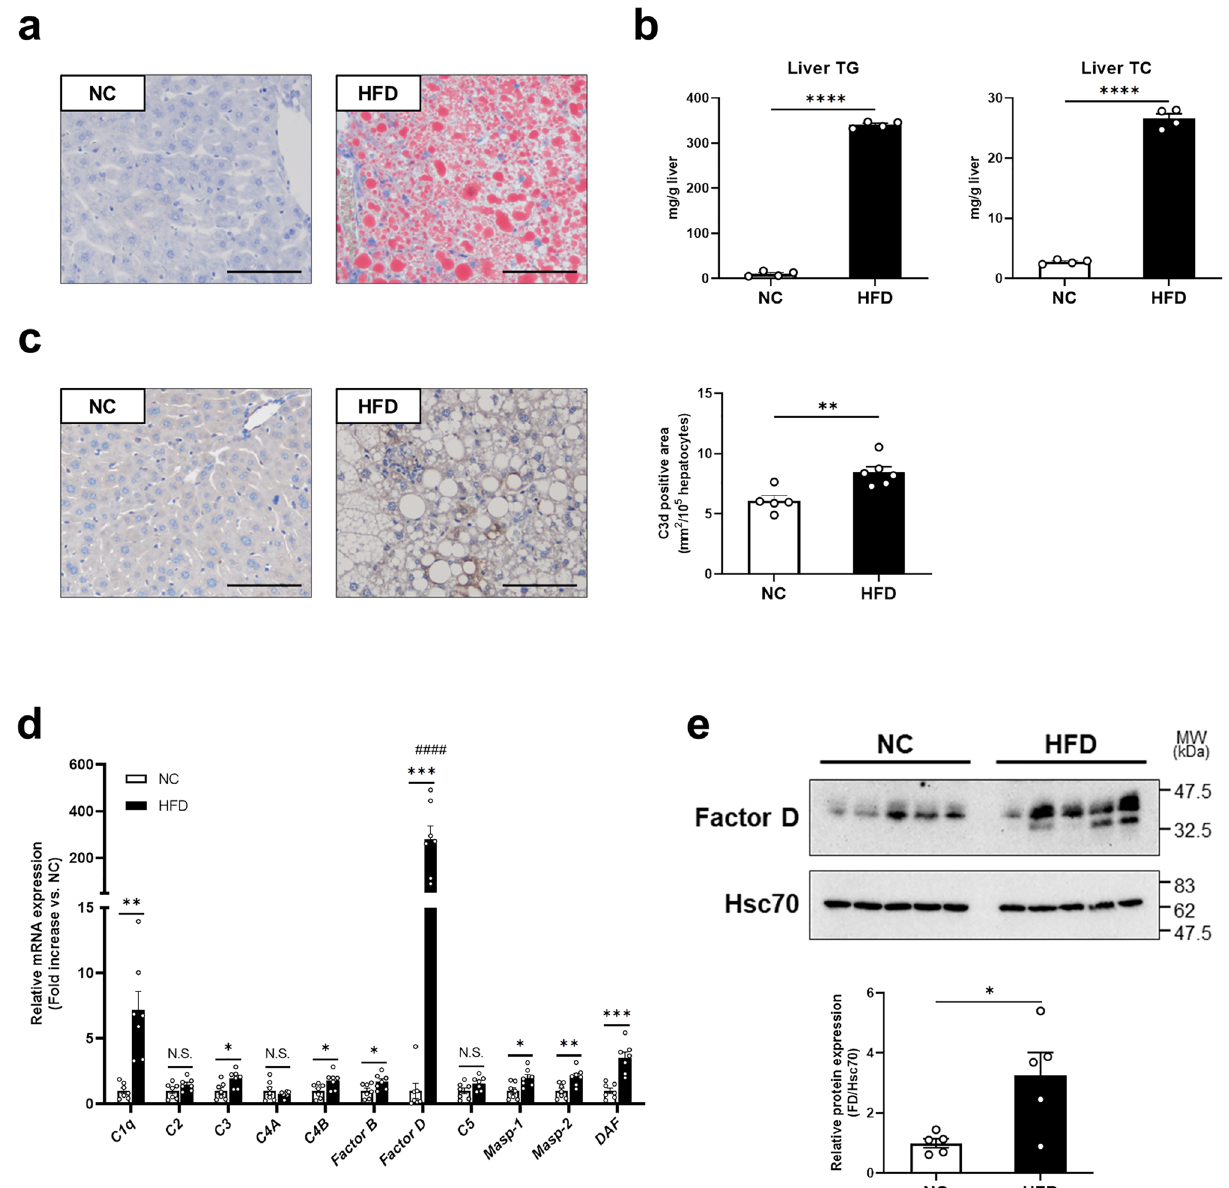
Figure 1. HFD for 17 weeks remarkedly increased hepatic lipid accumulation and Factor D expression in WT mice. (a ) Images of Oil Red O staining for sections of livers. HFD-feeding enhanced lipid accumulation. Bars, 100 μm. Magnification, × 20 objective. ( b) TG or TC levels in liver. TG or TC level in liver increased by HFD. N = 4 per group. **** p < 0.0001 by an unpaired two-sided t test. ( c ) Images of immunohistochemistry for C3d in liver (left panels). Bars, 100 μm. Magnification, × 20 objective. ( c ) Right graph showed quantification of C3d-positive area. HFD increased C3d deposition in mice. N = 5, 6. * p < 0.01 by an unpaired two-tailed t test. ( d ) Relative mRNA expression levels of complement components in liver of WT mice fed NC or HFD. N = 7 in each group. * p < 0.05, ** p < 0.01, *** p < 0.001 by an unpaired two-tailed t test. #### p < 0.0001 were calculated using one-way ANOVA with Dunnett’s multiple comparisons test. ( e ) Representative images of western blotting for Factor D in liver (upper panels) and graph for relative Factor D expression levels normalized to Hsc70 (lower panel). Specific bands disappeared in FD-KO mice (Supplementary Fig. 1c, d). These images were cropped and the full images were shown in Supplementary Fig. 1. N = 5 in each group. * p < 0.05 by an unpaired two-tailed t test. Data are shown as mean ±